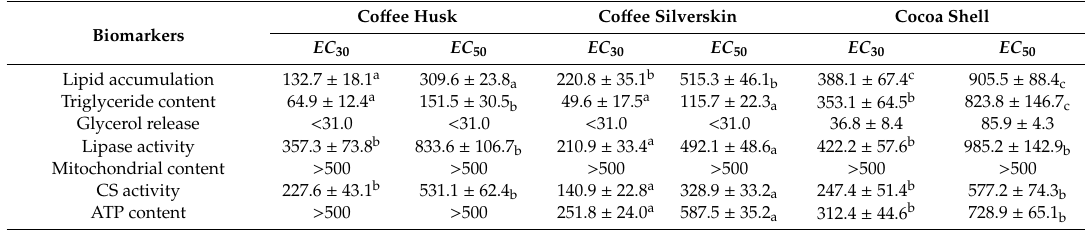
Table 4. Anti-adipogenic e ff ect of co ff ee husk, co ff ee silverskin, and cocoa shell extracts (31–500 µ g / mL) modulating lipid accumulation, intracellular triglyceride content, extracellular glycerol release, lipase activity, mitochondrial content, citrate synthase (CS) activity, and ATP content in 3T3-L1 adipocytes. Values are expressed as mean ( µ g / mL) ± SD ( n = 3). Di ff erent letters among rows indicate significant di ff erences ( p < 0.05) according to ANOVA and Tukey’s multiple range test.